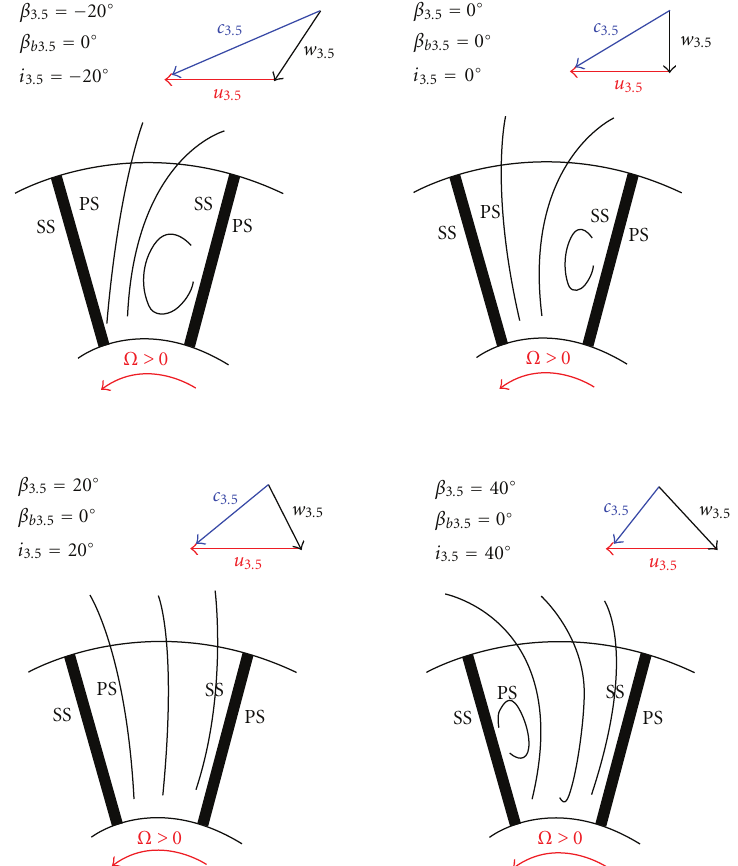
Figure 5: Radial flow turbine inflow characteristics for di ff erent incidence